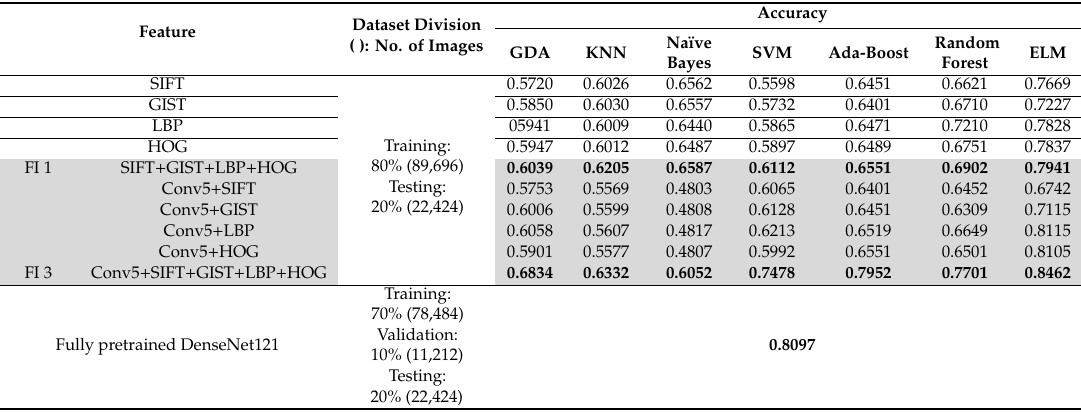
Table 1. Accuracies of the classifiers using the feature(s) w / or w / o the feature integration approach. Feature